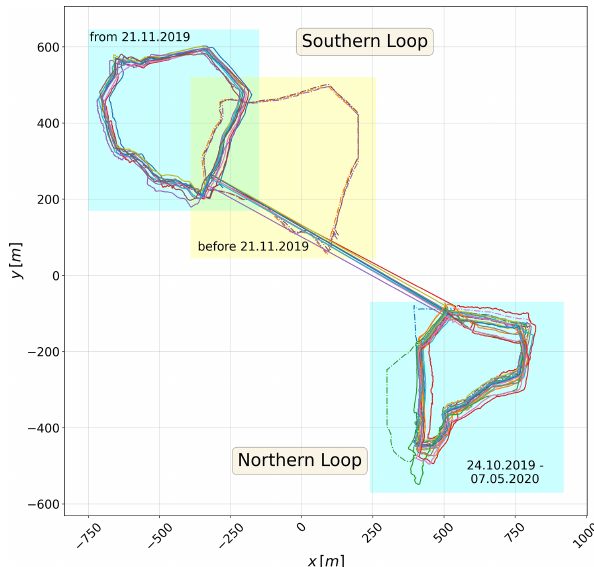
Figure 3. Magnaprobe transect paths with coordinates transformed to the FloeNavi grid corrected for ice drift. The rectangles represent the margins that were used as a definition for the “northern tran- sect loop” (upper left) and “southern transect loop” (bottom right) for good comparability. The shifts between transect paths within a rectangle originate from corrections and coordinate transformation, though the actual transect paths were the